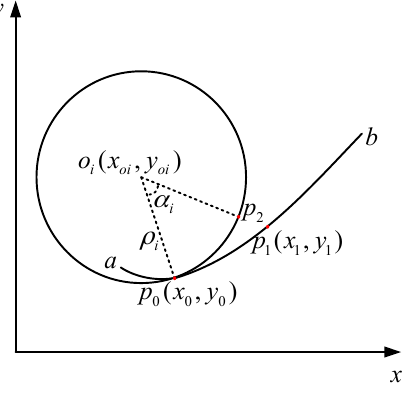
Figure 11. Schematic diagram of error measurement.